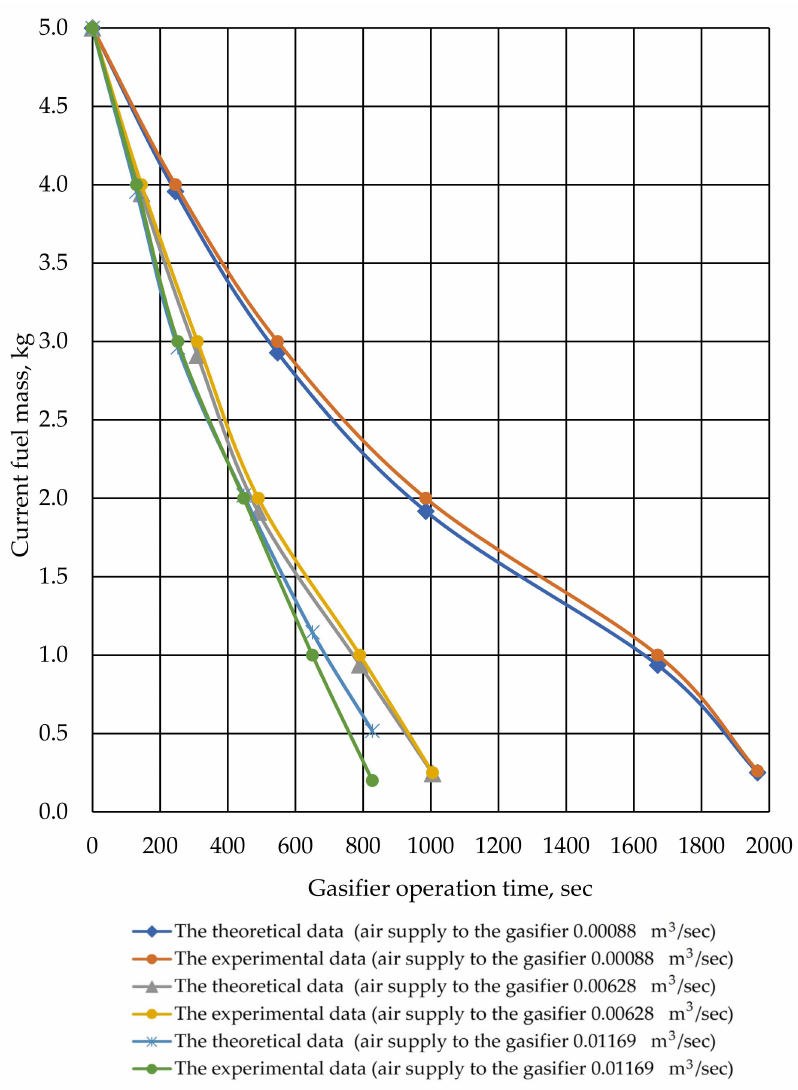
Figure 3. Comparison of the experimental and theoretical indicators of a change of fuel mass when using straw pellets.